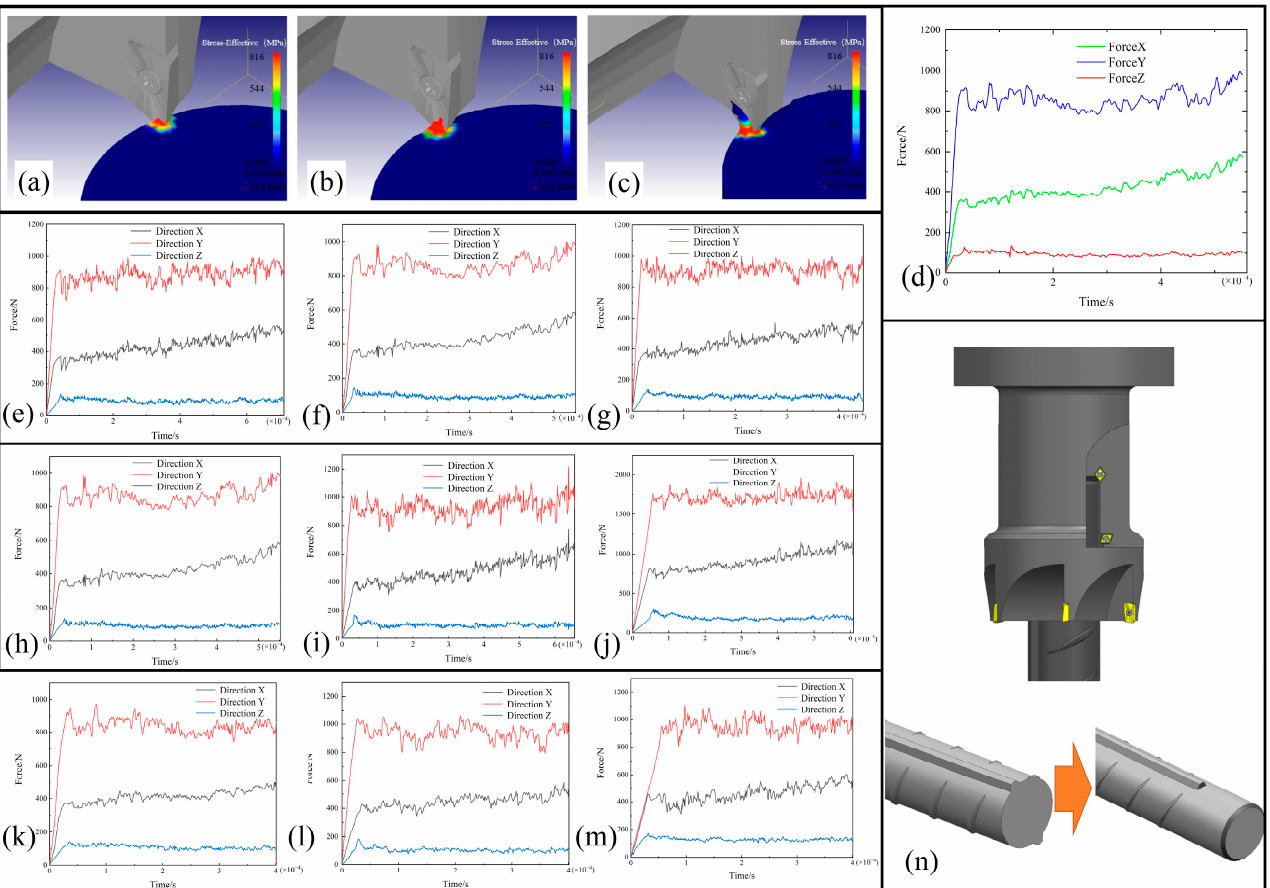
Figure 5. E × ploring the influence of cutting parameters on cutting force. ( a – c ) Simulation of cutting process: stages of ( a ) plastic deformation, ( b ) shear slip, and ( c ) chip formation. ( d ) Curve of cutting force variation. ( e – g ) Cutting force in different directions: the speed of ( e ) 300 r/min, ( f ) 400 r/min, and ( g ) 500 r/min. ( h – j ) Cutting force in different directions: the feed rate per tooth of ( h ) 0.12 mm/z, ( i ) 0.15 mm/z, and ( j ) 0.18 mm/z. ( k – m ) Cu tt ing force in the Z direction. The depth of cu tt ing is ( k ) 2 mm, ( l ) 3 mm, and ( m ) 4 mm. ( n ) Composite tool cu tt ing ribs of surface.